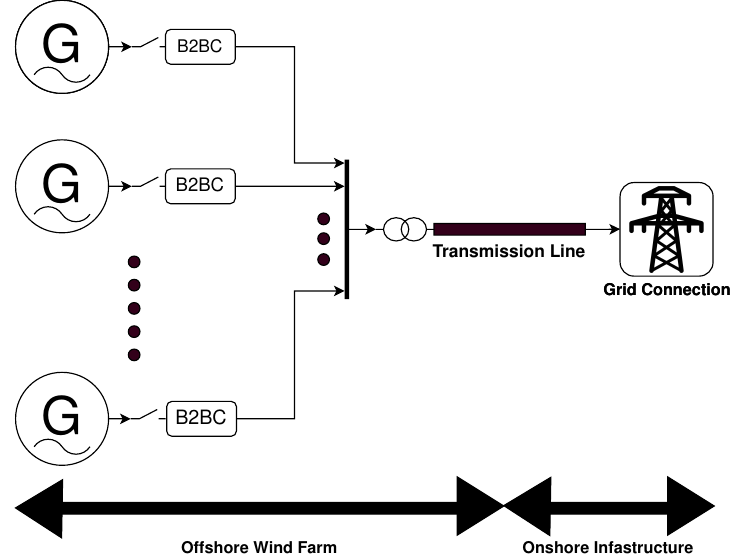
Figure 1. Traditional